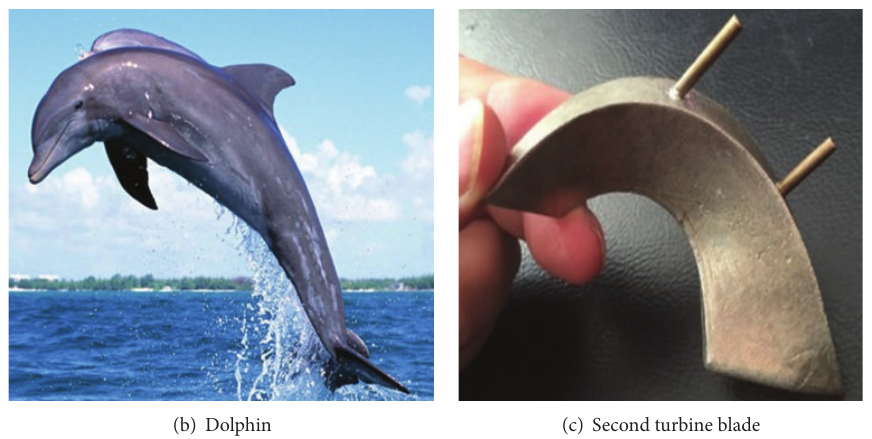
Figure 1: Similarity between torque converter blade and